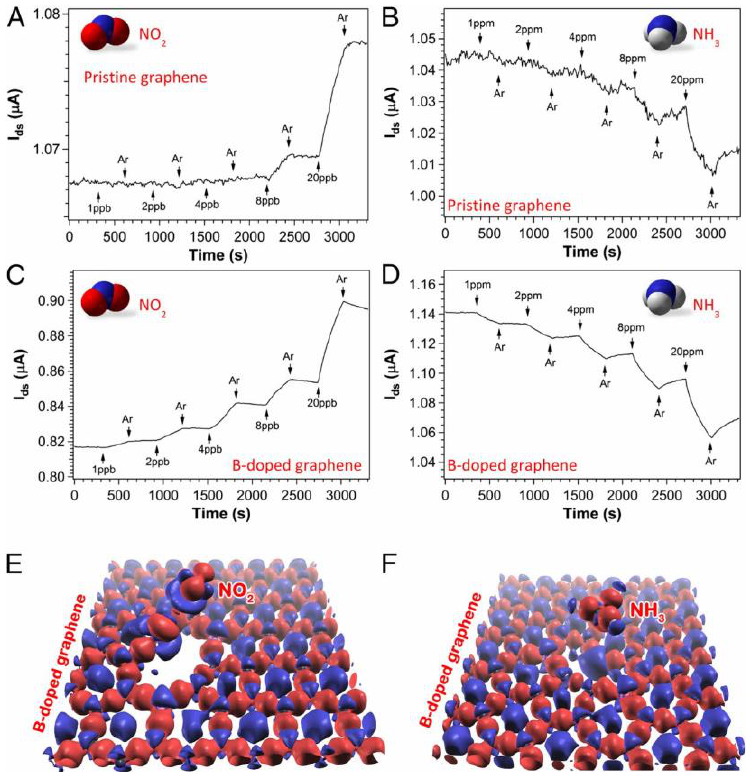
Figure 12. Sensor response of pristine graphene to NO 2 (panel ( A )) and NH 3 (panel ( B )) and of B-doped graphene to NO 2 (panel ( C )) and NH 3 (panel ( D )). UV illumination was active during all the experiments to maintain a fresh sensor. The difference in charge density with respect to isolated atoms is shown for NO 2 (panel ( E )) and NH 3 (panel ( F )) for B-doped graphene. Taken with permission from [61]. Copyright by National Academy of Sciences.